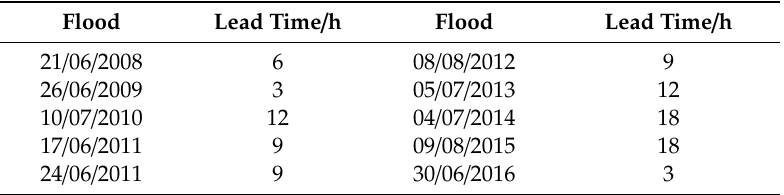
Table 3. Statistical value of the forecast lead time of historical